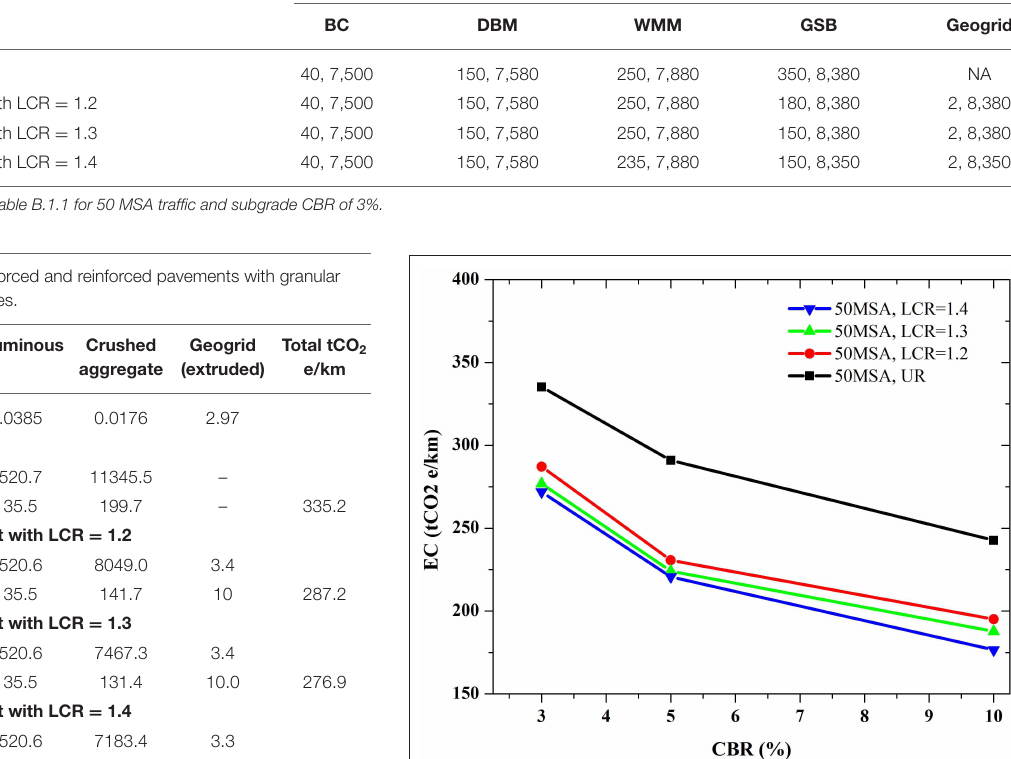
TABLE 5 | Pavement layer thickness and width details for unreinforced and geogrid-reinforced pavements with granular layer reduction in reinforced cases. Type of pavement